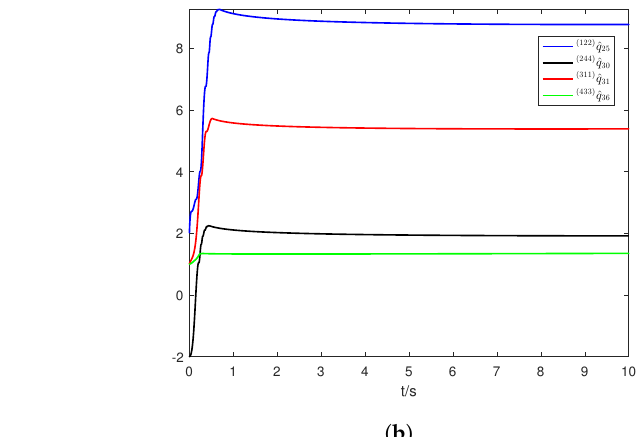
Figure 9. The estimation of parameters ( 122 ) ˆ r 25 , ( 244 ) ˆ r 30 , ( 311 ) ˆ r 31 , ( 433 ) ˆ r 36 and ( 122 ) ˆ q 25 , ( 244 ) ˆ q 30 , ( 311 ) ˆ q 31 , ( 433 ) ˆ q 36 shown in sub-pictures ( a , b